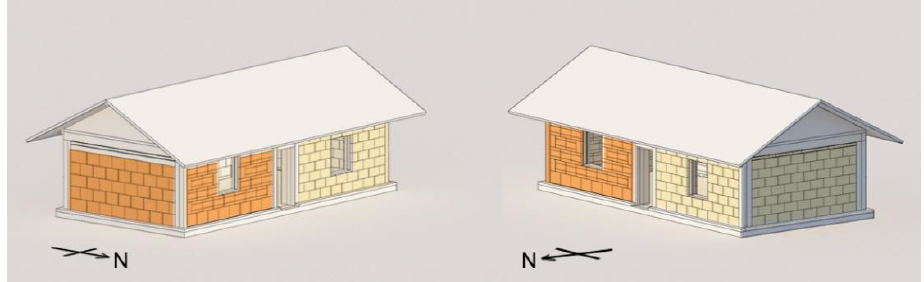
Figure 4. Perspective of the experimental building with laid flat straw bales ( light yellow ) and on edge straw bales ( dark yellow ).